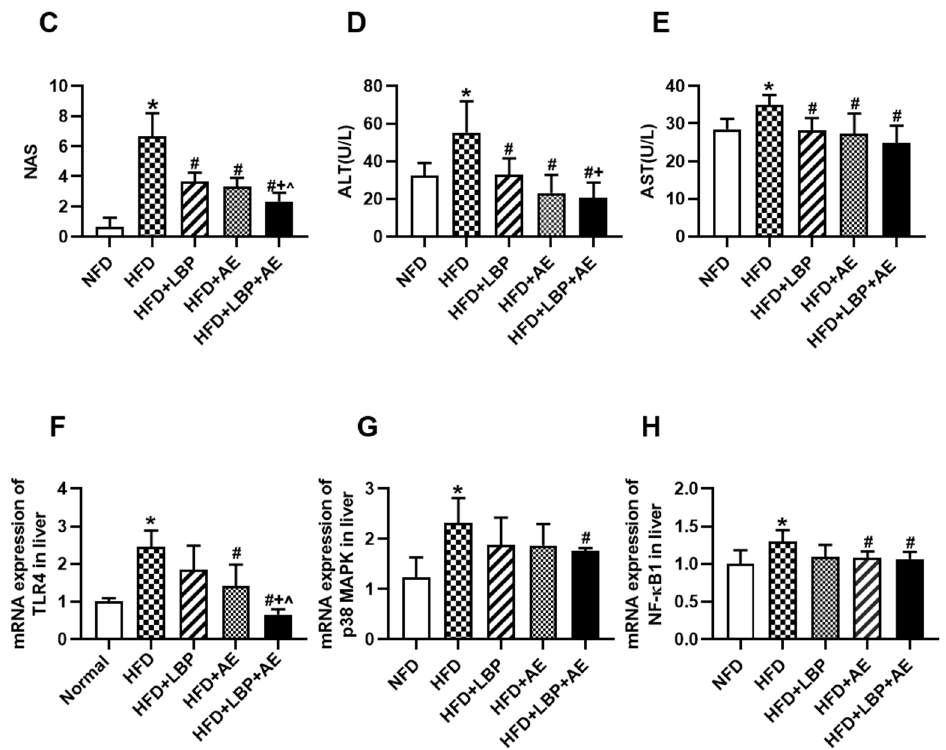
Figure 2. LBP plus AE ameliorated the hepatic injury. ( A ) Oil red O staining of the liver tissue was photographed at 200 × magnification. ( B ) Transmission electron microscopy of the liver histology was photographed at 6000 × magnification. White arrow: nucleus. Red arrow: mitochondrion. Green arrow: rough endoplasmic reticulum. ( C ) Hepatic NAS in different groups. ( D ) Serum levels of ALT. ( E ) Serum levels of AST. ( F ) mRNA expression of TLR4 in liver. ( G ) mRNA expression of p38 MAPK in liver. ( H ) mRNA expression of NF-kB1 in liver. * p < 0.05 vs. the NFD group. # p < 0.05 vs. the HFD group. + p < 0.05 vs. the HFD plus LBP group. ^ p < 0.05 vs. the HFD plus AE group.